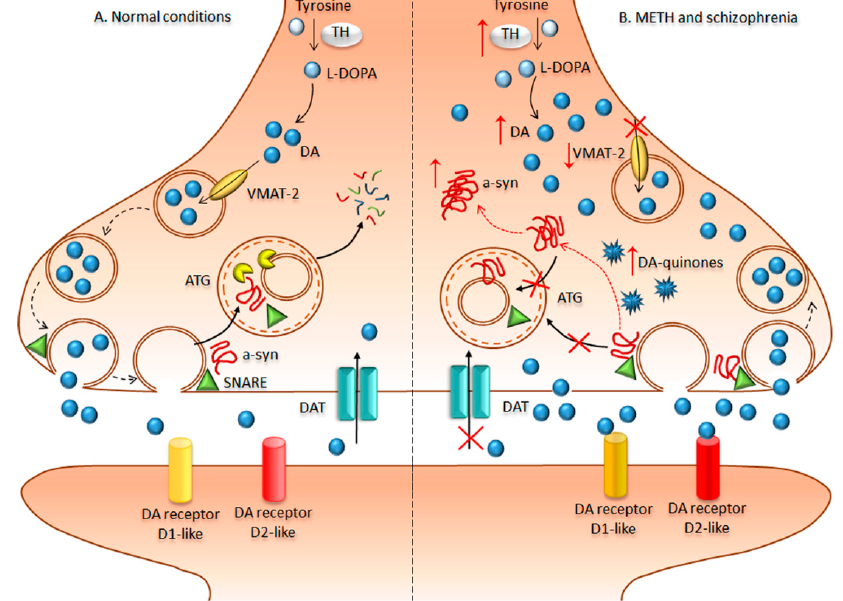
Figure 2. Overlap of dopamine-dependent molecular mechanisms underlying methamphetamine (METH) and schizophrenia. In normal conditions ( A ), the amount of intra-cytosolic dopamine is determined by the rate limiting enzyme tyrosine hydroxylase (TH), which converts tyrosine into L-dihydroxyphenylalanine (L-DOPA) and eventually dopamine (DA). DA is selectively taken-up into synaptic vesicles by the vesicular monoamine transporter type-2 (VMAT-2), which is key to surveil the physiological storage of vesicular DA. DA-containing synaptic vesicles are coated with soluble NSF (N-ethylmaleimide-sensitive factor) attachment protein receptor (SNARE) proteins co-chaperoned by alpha-synuclein, which mediate docking, priming, and release of DA-synaptic vesicles via exocytosis. Once exocytosis has occurred, synaptic vesicles and their associated proteins are endocytosed and sorted for autophagy (ATG) degradation. In this way, ATG monitors the amount of releasable DA synaptic vesicles, thus playing a key role in restraining DA release and in the turnover of synaptic proteins. In the synaptic cleft, the dopamine transporter (DAT) is key to take-up extracellular DA in order to guarantee a physiological stimulation of post-synaptic DA receptors. On the other hand, METH addicted and schizophrenic brains ( B ) feature alterations of DA metabolism and handling, which consist of the following: (i) increased levels of TH, which produces high levels of intra-cytosolic DA; (ii) a decrease in VMAT-2, which leads to a loss of DA vesicular storage and increases the amount freely diffusible intra-cytosolic DA; (iii) free cytosolic DA is highly prone to auto-oxidation into reactive DA-quinones, which produce structural modifications of presynaptic proteins such as alpha synuclein;